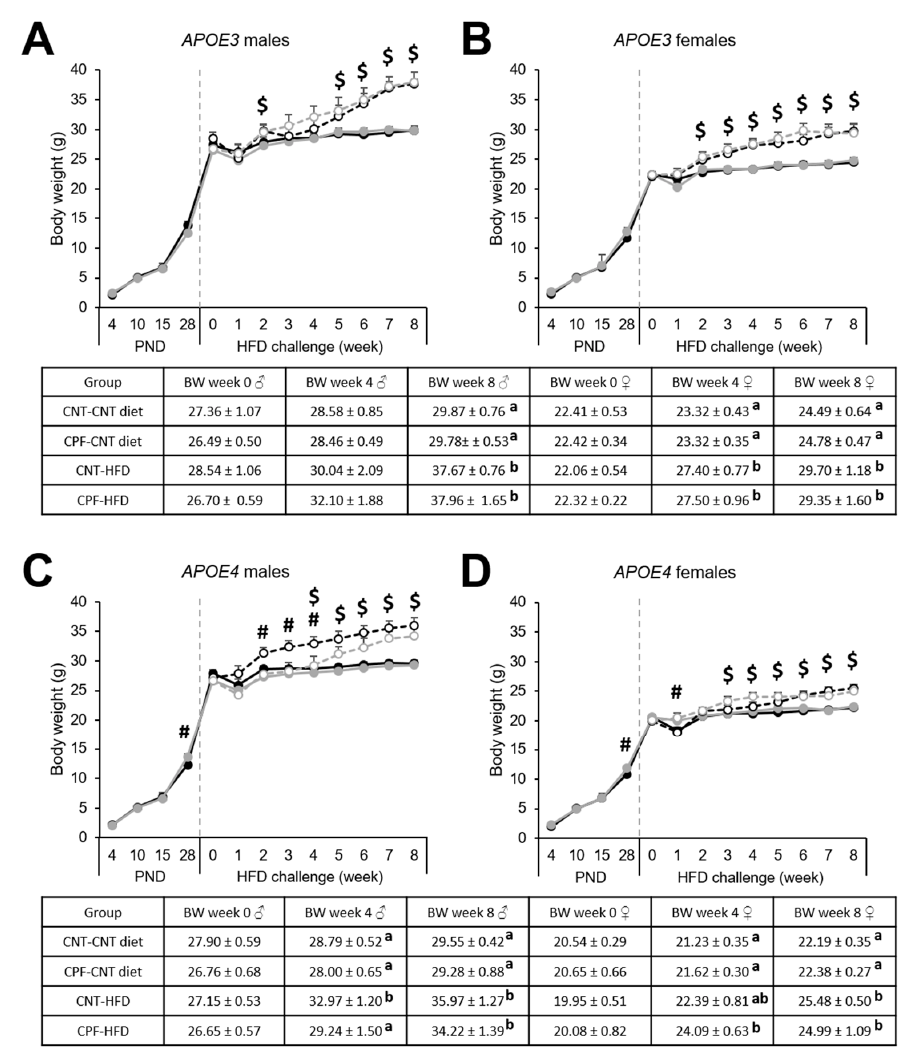
Figure 6. Body weight progression during the postnatal period and the high-fat diet for APOE3 males ( A ), APOE3 females ( B ), APOE4 males ( C ), and APOE4 females ( D ), with the BW of week 0, week 4 and week 8 described in the corresponding table. The symbol $ indicates a significant effect of the diet at p < 0.05, while the symbol # represents a significant effect of the treatment at p < 0.05. Different letters (a, b) represent significant differences at p < 0.05. Abbreviations: CNT, control; CPF, chlorpyrifos-treated; HFD, high-fat diet. Data is contained within the Supplementary File